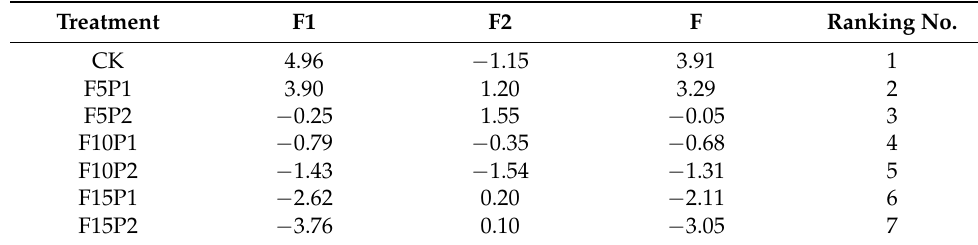
Table 4. The principal component indexes of CSL.